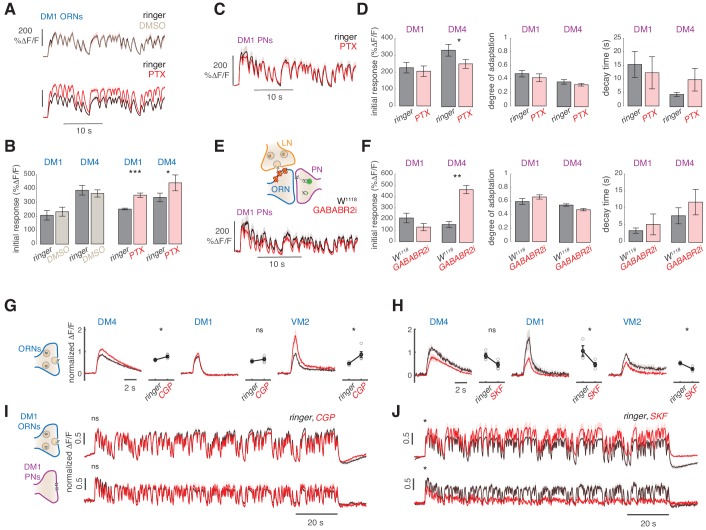
Slow adaptation in the PN calcium signal is not driven by lateral inhibition.(A–D) Application of the GABA-A receptor antagonist PTX does not affect calcium adaptation in PNs. (A) Application of 5 μM PTX enhances the calcium response from ORN terminals in glomerulus DM1. Top: Calcium response to randomly fluctuating odor stimulation (methyl acetate) before and after application of an equivalent DMSO control (n = 4). Bottom: Calcium response before and after application of 5 μM PTX (n = 6). Shaded areas indicate SEM. (B) PTX enhances the response to the first odor pulse measured from ORNs in glomeruli DM1 and DM4. Paired t test, *p<0.05, ***p<0.001. Error bars indicate SEM. (C) Mean calcium signals from PNs in DM1 in response to random stimulation before (black) and after (red) PTX application. Shaded areas indicate SEM (n = 10). (D) Initial response r0, degree of adaptation d, and decay timescale τ of PN activity under sustained random stimulation for glomeruli DM1 and DM4 before and after PTX application, calculated by fitting an exponential decay function to the peak response to each odor pulse in the random sequence (Figure 5—figure supplement 1). Error bars indicate SEM. PTX application slightly decreases DM4 response but has no effect on the other parameters (paired t test, n = 10). (E) Schematic illustration of GABA-B-R2 RNAi-mediated down-regulation and simultaneous expression of the calcium reporter GCaMP3 in PNs. Bottom: Mean calcium signal from DM1 PNs in flies expressing GABA-B-R2-RNAi and in control w1118 flies. Shaded areas indicate SEM (n = 5). (F) GABA-B-R2-RNAi expression affects the initial response r0 but not the degree of adaptation d and the decay timescale τ of PNs activity in glomeruli DM1 and DM4 (**p<0.01, Mann-Whitney U-test, n = 5). Also see Figure 5—figure supplement 1. (G) Mean response of ORNs from DM4 and DM1 (methyl acetate 10-4.3 dilution) and VM2 (ethyl butyrate 10-7.5) to a 1 s pulse, in control flies (black) or in flies treated with 25μM CGP54626 (GABA-B antagonist). (*p<0.05, ***p<0.001, Kruskal-Wallis test, n = 3-5). In both test and control flies, the odor response was first quantified in normal ringer. The ringer was then replaced with new ringer in control flies and with ringer + CGP54626 in test flies. Odor response was tested again 8 minutes after drug application. The response in presence of the drug was then normalized to the response to the first presentation of the odor to account for fluctuation in the odor concentration. (H) Same as in (G) with 40μM SKF97541 (GABA-B agonist) (*p<0.05, **p<0.01, Kruskal-Wallis test, n = 3-4). (I) Mean response of ORNs and PNs from DM1 to a random stimulus sequence (methyl acetate 10-4.3 dilution) in ringer (black) or in CGP54626 (red). Response is normalized in each fly to the mean response to the first odor pulse obtained in ringer. No change was observed after drug application (n=6-8), similarly to control flies treated with ringer (not shown). (J) Mean response of ORNs and PNs from DM1 to a random stimulus sequence (methyl acetate 10-4.3 dilution) using ringer (black) or SKF97541 (red). Response is normalized in each fly to the mean response to the first odor pulse obtained in ringer. Response to the first odor pulse is lower in both ORNs and PNs after drug application (paired t-test, n=5-6).